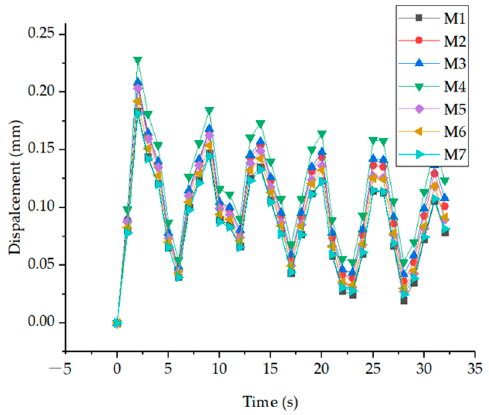
Figure 13. Curve of time and displacement.